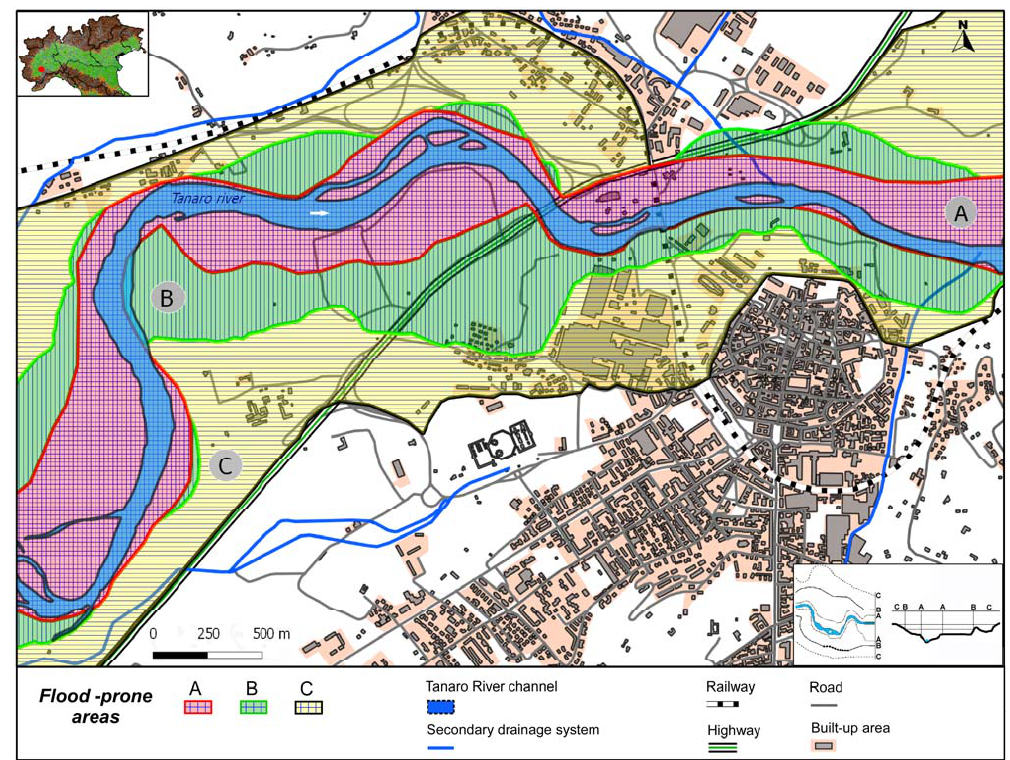
Fig. 9 – Alba: subdivision of the Tanaro valley bottom in three different river corridors. A = ordinary floodplain, B = 200-year return period floodplain, C = 500-year return period floodplain. In the lower-right corner the general outline for defining river corridors adopted by the Basin Authorities (Autorità di Bacino del Fiume Po, 1997). Fig. 10 – A risk matrix with three different classes that identify the areas exposed to flooding: green (low degree of damage) to red (high degree of damage).